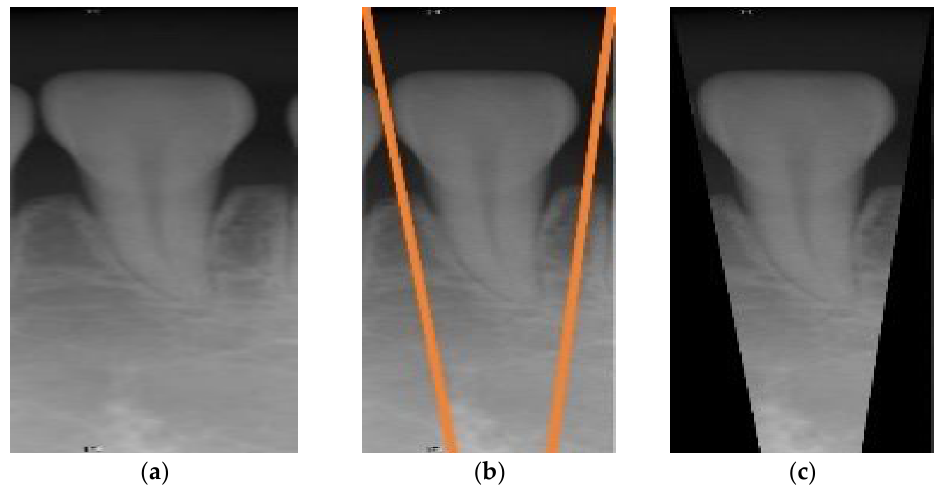
Figure 5. ( a ) The photo output after Image cropping, ( b ) the schematic diagram of Image retouch- ing (the orange line is the cutting line, between the orange line is the target, and the rest of the area is the non-target), ( c ) the image after retouching.